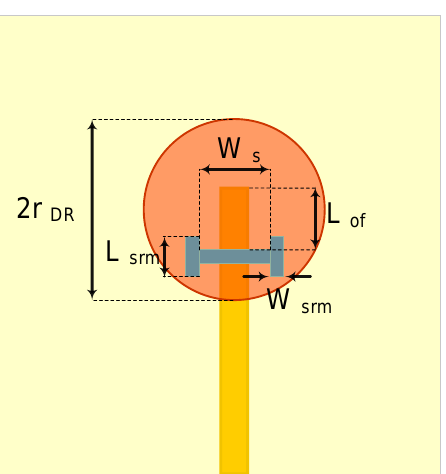
Figure 2. The schematic of the proposed single element CDRA (top view).